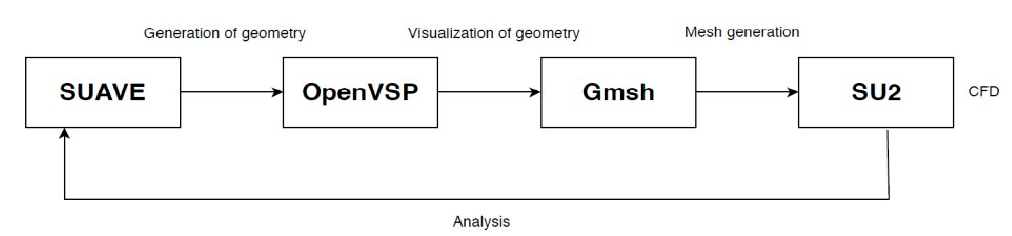
Figure 5. Sequential build-up from Stanford University Aerospace Vehicle Environment (SUAVE) geometry and to SU2 CFD analysis.